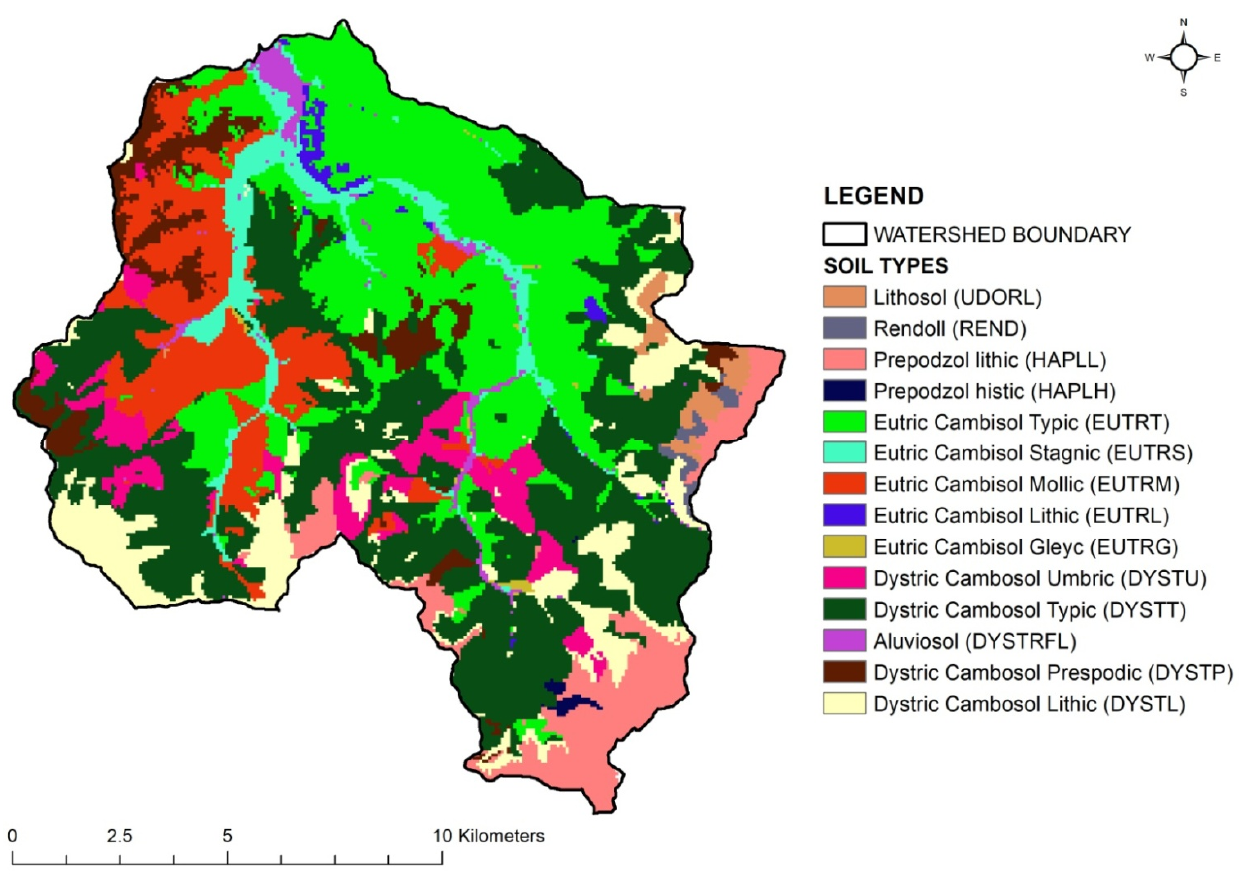
Figure 3. Soil types within the Tărlung watershed.